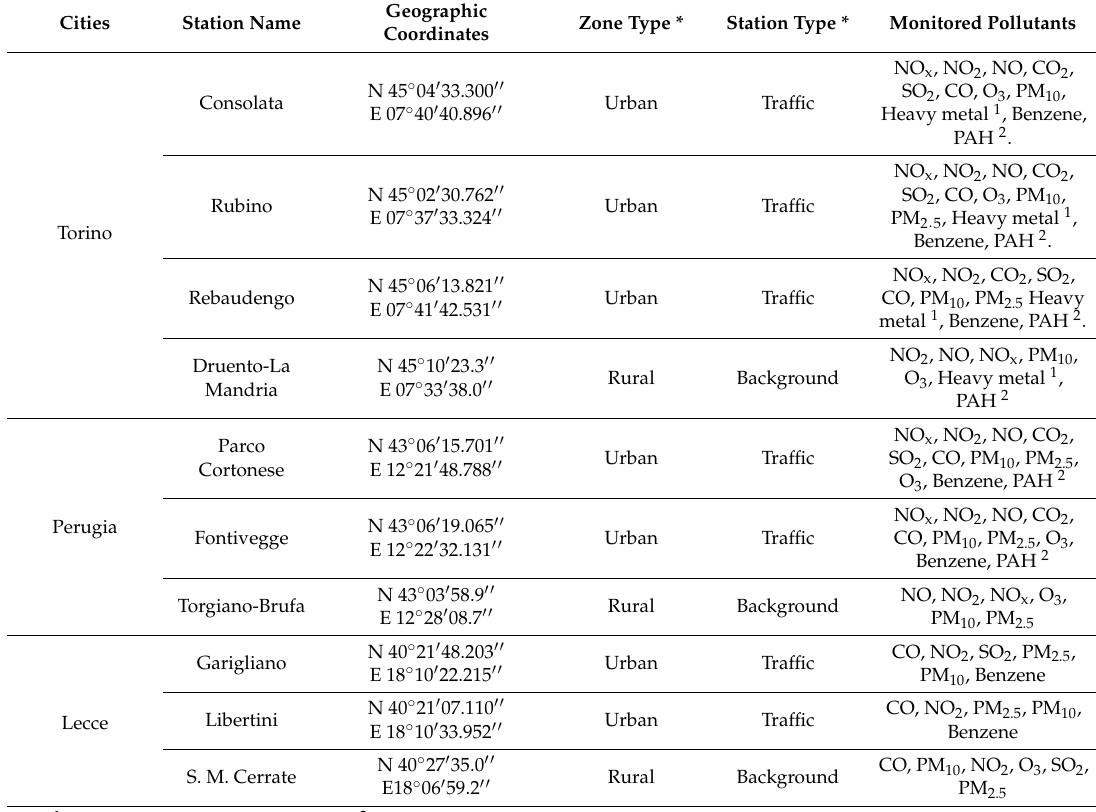
Table 1. List of monitoring stations and pollutants detected in the three study